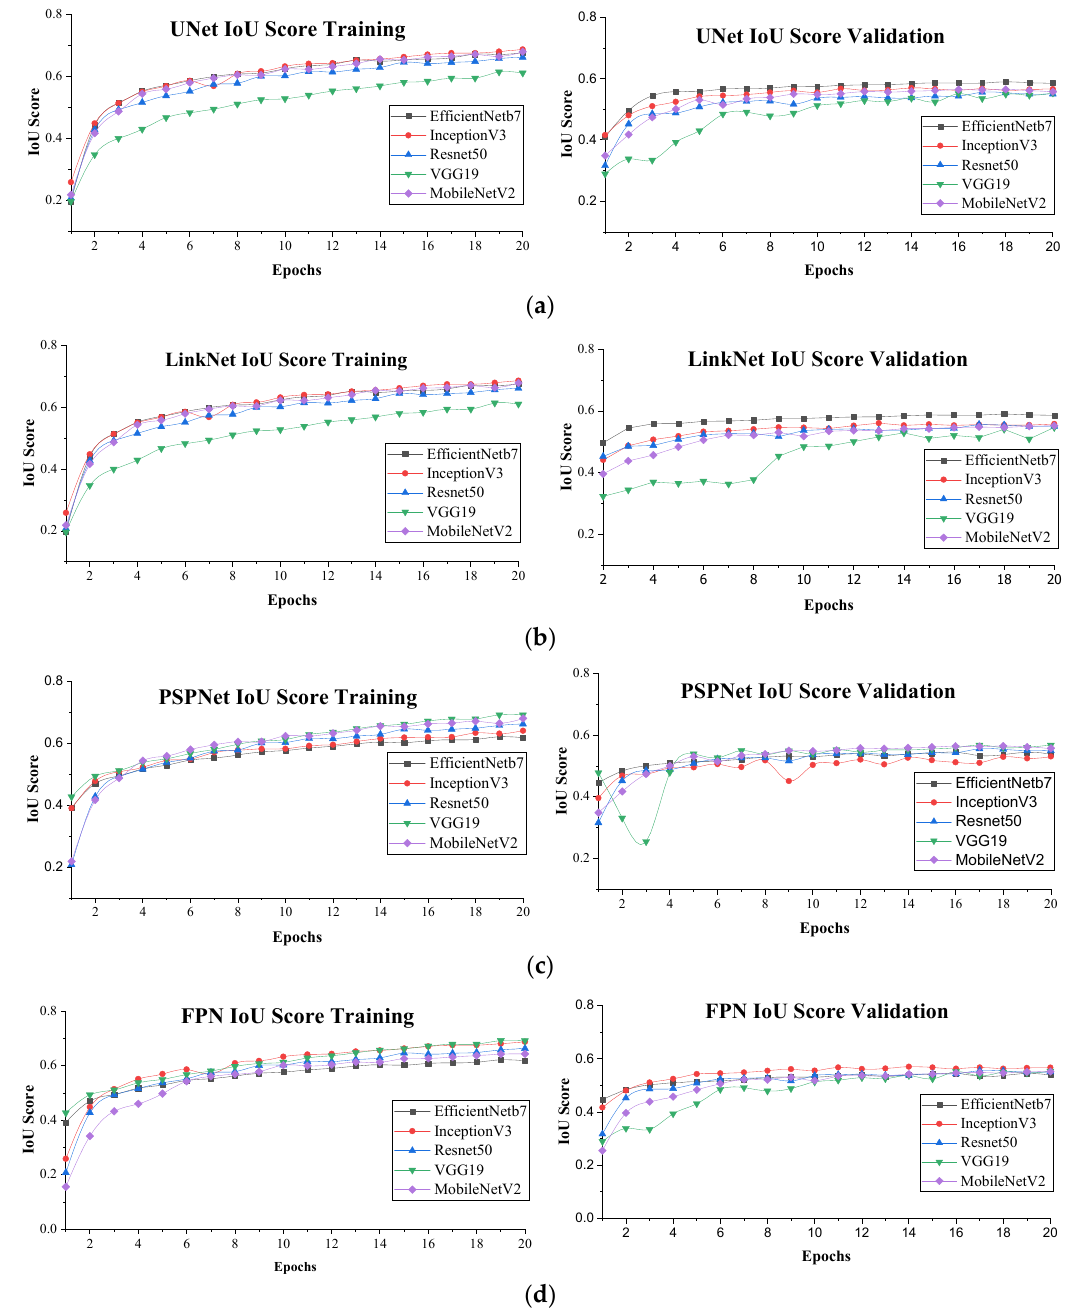
Figure 4. Jaccard Index (IoU Score) value for training and validation datasets for four Segmentation Models with different backbones. ( a ) U-Net; ( b ) Linknet; ( c ) PSPNet; and ( d ) FPN.